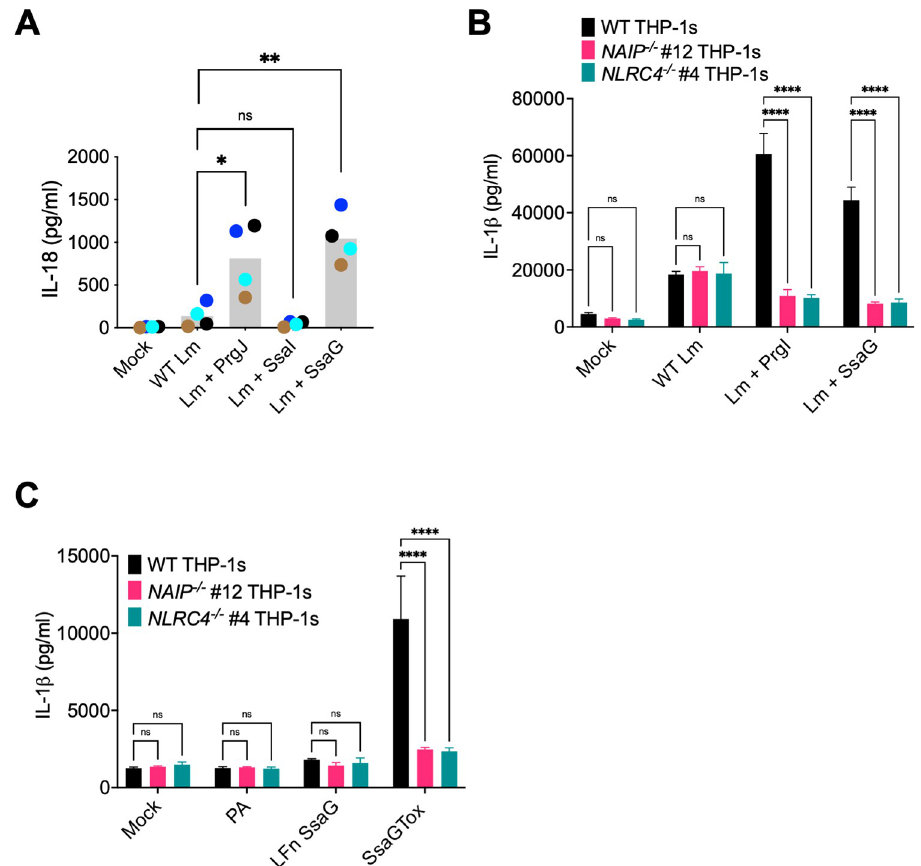
Fig 7. Salmonella SPI-2 needle protein SsaG activates the NAIP/NLRC4 inflammasome in human macrophages. (A) Primary hMDMs from four healthy human donors were infected with PBS (Mock), WT Listeria ( WT Lm ) , Listeria expressing PrgJ (Lm + PrgJ), SsaI (Lm + SsaI), or SsaG (Lm + SsaG) for 16 hours at MOI = 5. Release of IL-18 into the supernatant was measured by ELISA. Each dot represents the mean of individual donors derived from triplicate wells. The grey bar represents the mean of all donors. (B) WT, NAIP -/- , and NLRC4 -/- THP-1 monocyte-derived macrophages were primed with 100 ng/mL Pam3CSK4 for 16 hours. Cells were treated with PBS (Mock), WT Listeria ( WT Lm ) , Listeria expressing PrgI (Lm + PrgI), or Listeria expressing SsaG (Lm + SsaG) for 6 hours at MOI = 20. Release of IL-1 β into the supernatant was measured by ELISA. (C) WT, NAIP -/- , and NLRC4 -/- THP-1 monocyte- derived macrophages were primed with 100 ng/mL Pam3CSK4 for 16 hours. Cells were then treated with PBS (Mock), PA alone, LFnSsaG, or PA+LFnSsaG (SsaGTox) for 6 hours. Release of IL-1 β into the supernatant was measured by ELISA. ns–not significant, ��� p < 0.001, ���� p < 0.0001 paired t-test (A) or by Dunnett’s multiple comparisons test (B, C). Data shown are representative of at least three independent experiments. secretion and cell death (Figs 7B and S11A–S11C). Infection of WT THP-1s with Listeria expressing PrgI or SsaG led to robust release of IL-1 cytokines and cytotoxicity. In contrast, NAIP -/- and NLRC4 -/- THP-1s infected with Listeria expressing PrgI or SsaG released signifi- cantly reduced levels of IL-1 cytokines and cell death relative to WT THP-1s that were compa- rable to the background levels secreted by THP-1s infected with WT Lm (Figs 7B and S11A– S11C). We observed a similar phenotype when we delivered SsaGTox into the cytosol of THP- 1s. WT THP-1s released robust levels of IL-1 β , IL-18, and IL-1 α , whereas NAIP -/- and NLRC4 -/- THP-1s released negligible levels of IL-1 cytokines (Figs 7C, S11D and S11E). Alto- gether, these data demonstrate that the SPI-2 needle protein activates the human NAIP/ NLRC4 inflammasome, providing evidence that human NAIP can sense and respond to the Salmonella SPI-2 T3SS needle.